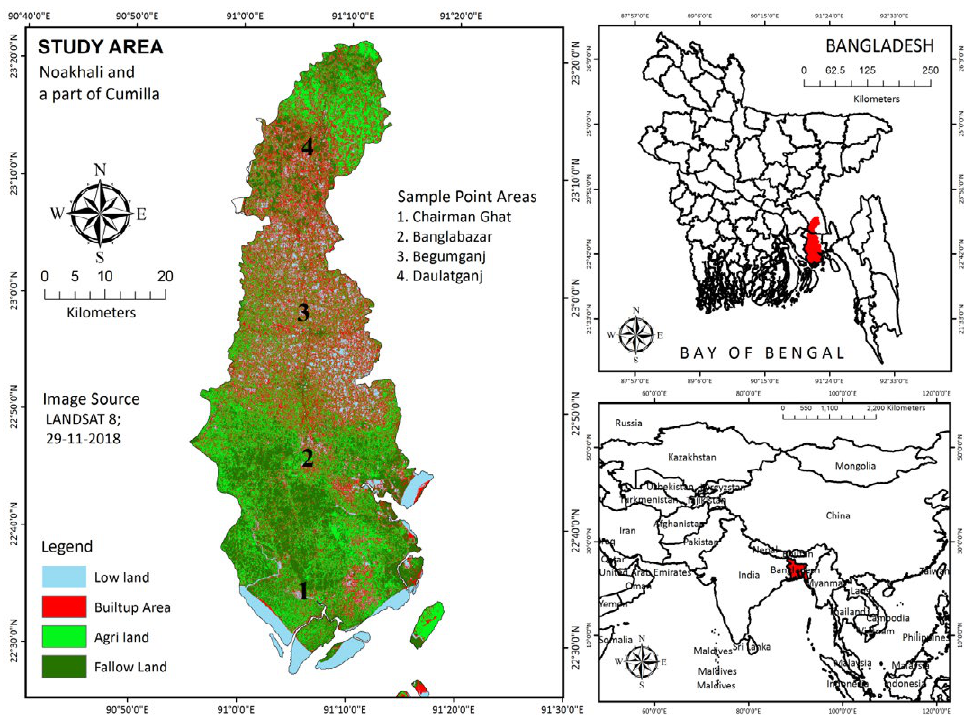
Fig. 1: Geographical location of the study area at coastal district Noakhali and a part of Cumilla, Bangladesh